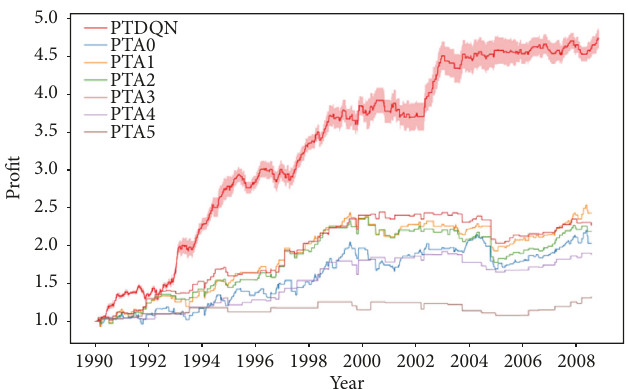
Figure 10: Average top-5 profits generated by PTDQN and traditional pairs-trading strategies using OLS in training